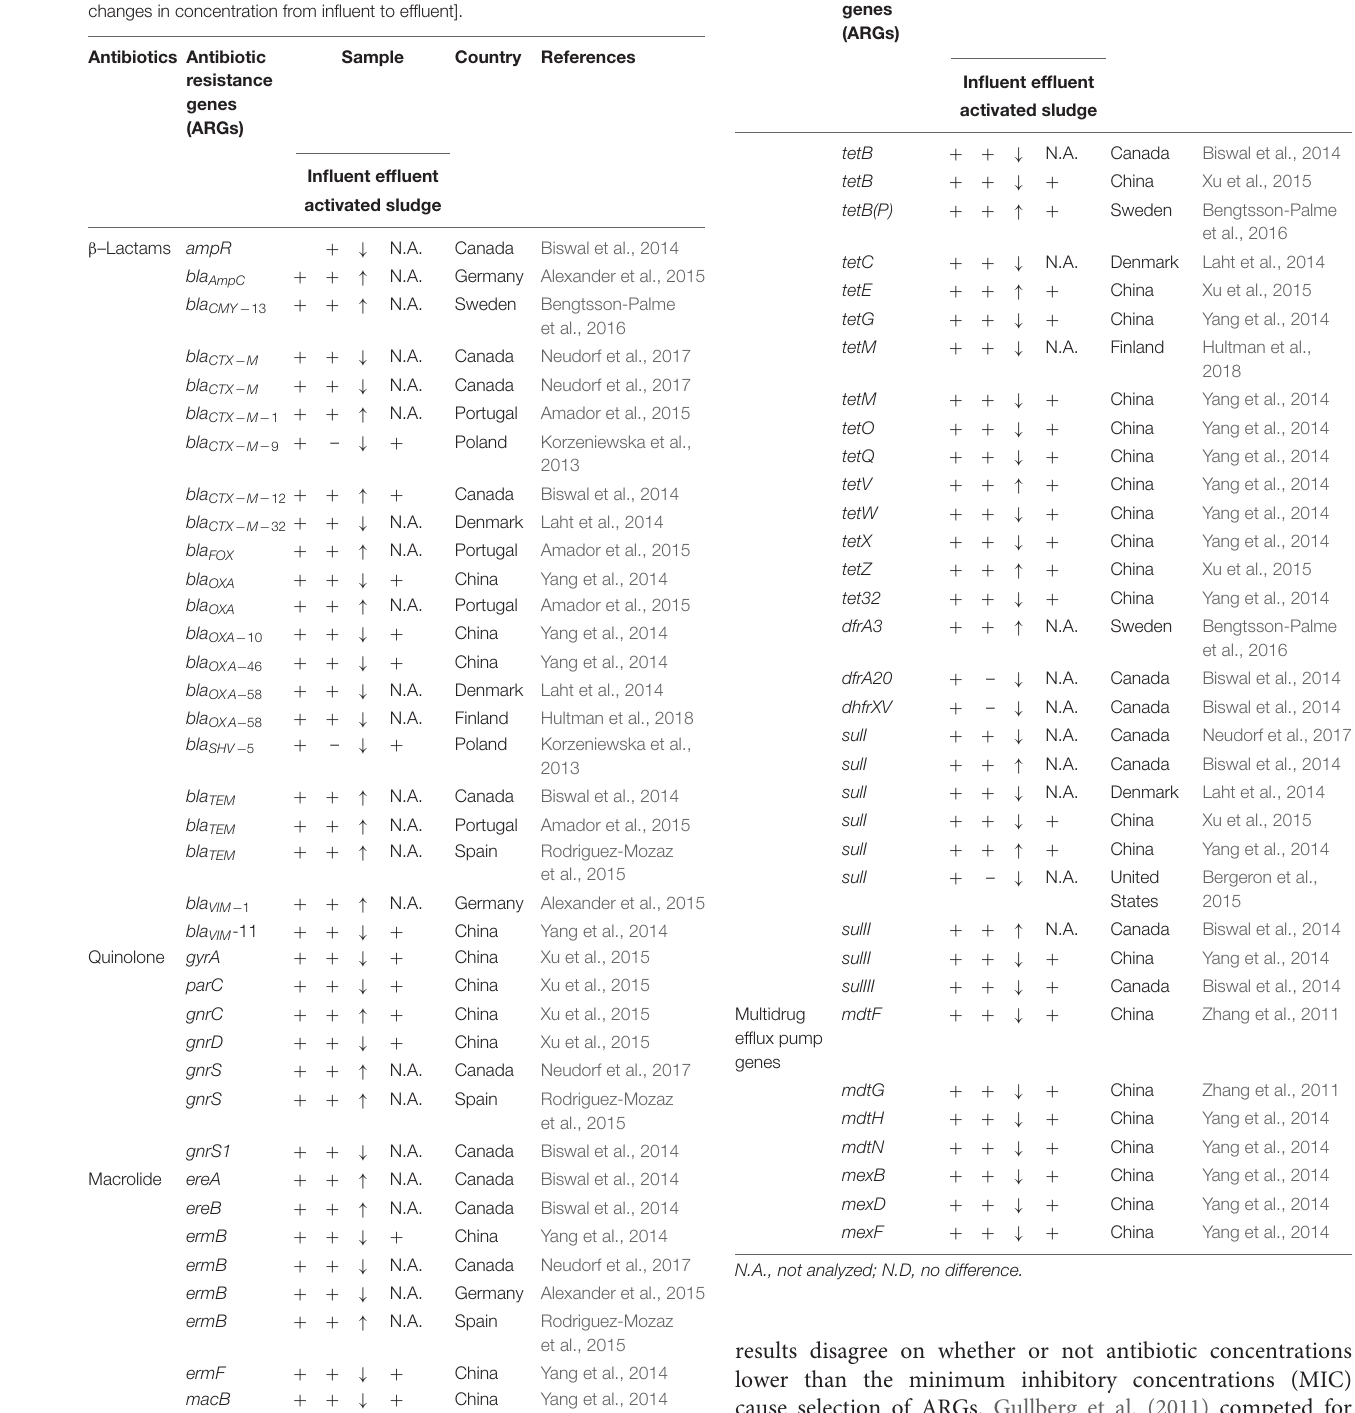
TABLE 1 | Overview of antibiotic resistance genes (ARGs) found in influent, effluent, and activated sludge in wastewater treatment plants (WWTPs) and if their concentrations increase ( ↑ ) or decrease ( ↓ ) from influent to effluent [adapted from Pazda et al. (2019) and shortened to only include studies that have measured changes in concentration from influent to